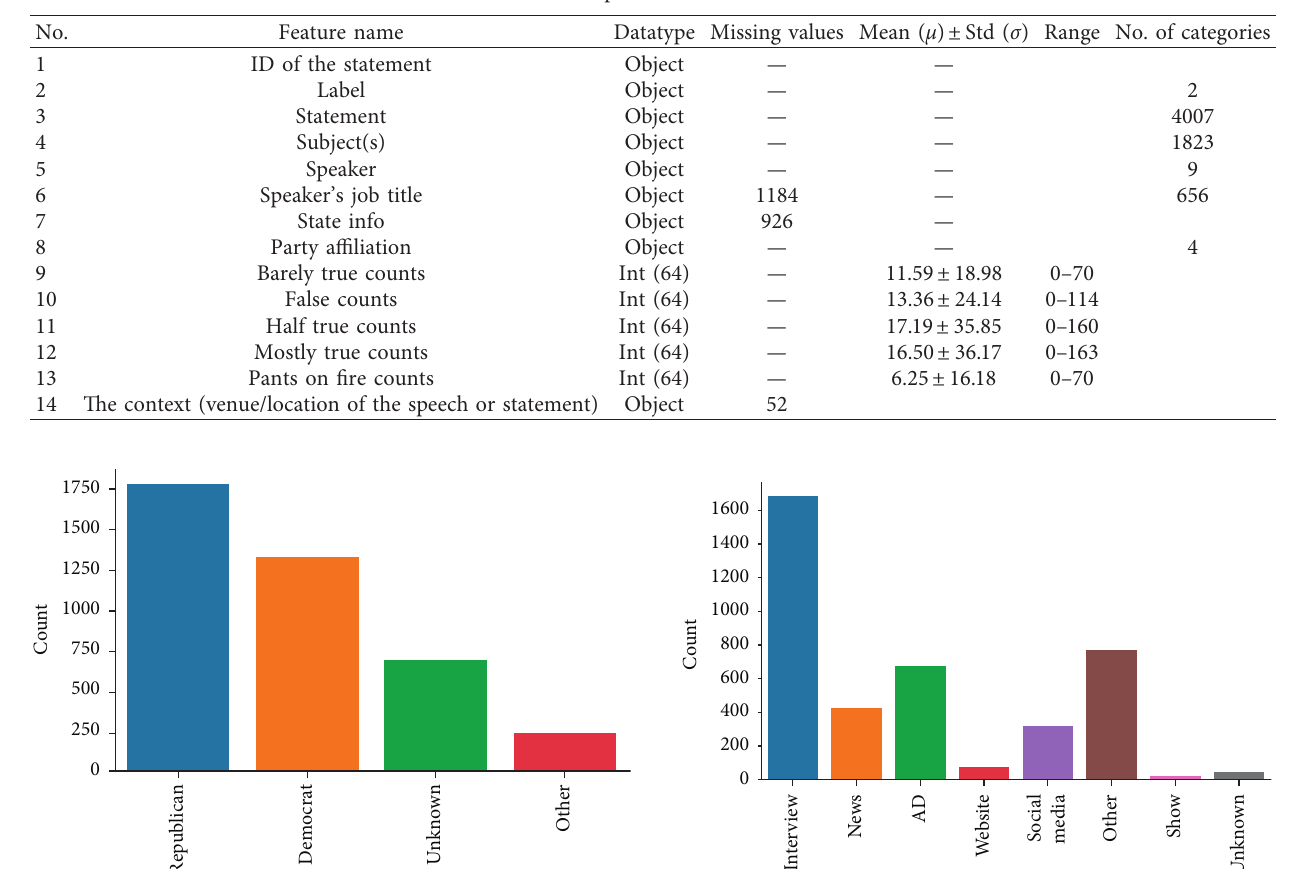
Figure 1: Block diagram of the proposed study methodology. Table 1: Description of the LIAR dataset.